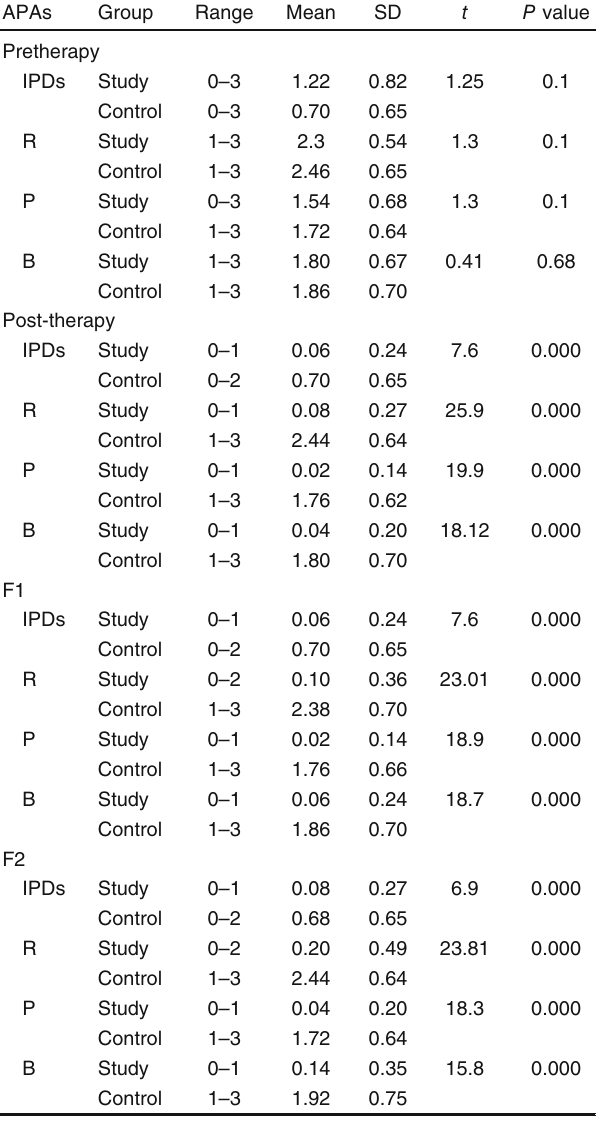
Table 2 Comparison between the study group and the control group as regards auditory perceptual assessment